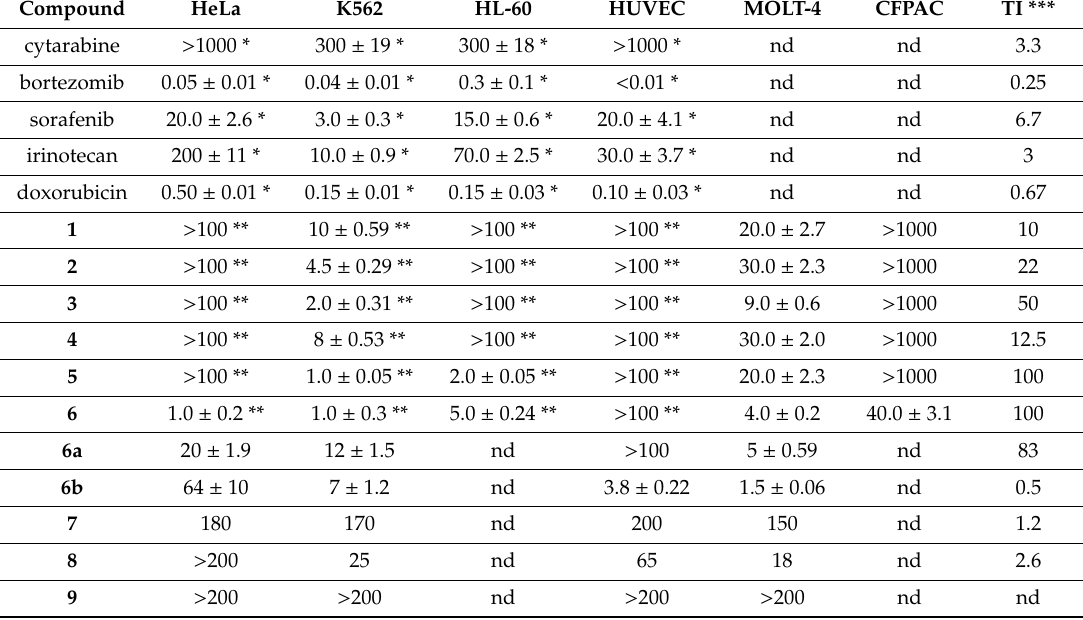
Table 2. Cytotoxicity of test compounds, cytarabine, bortezomib, sorafenib, irinotecan and doxorubicin in di ff erent cell lines after 48 h. IC 50 mean values [ µ M] ± standard deviation (SD) are shown.